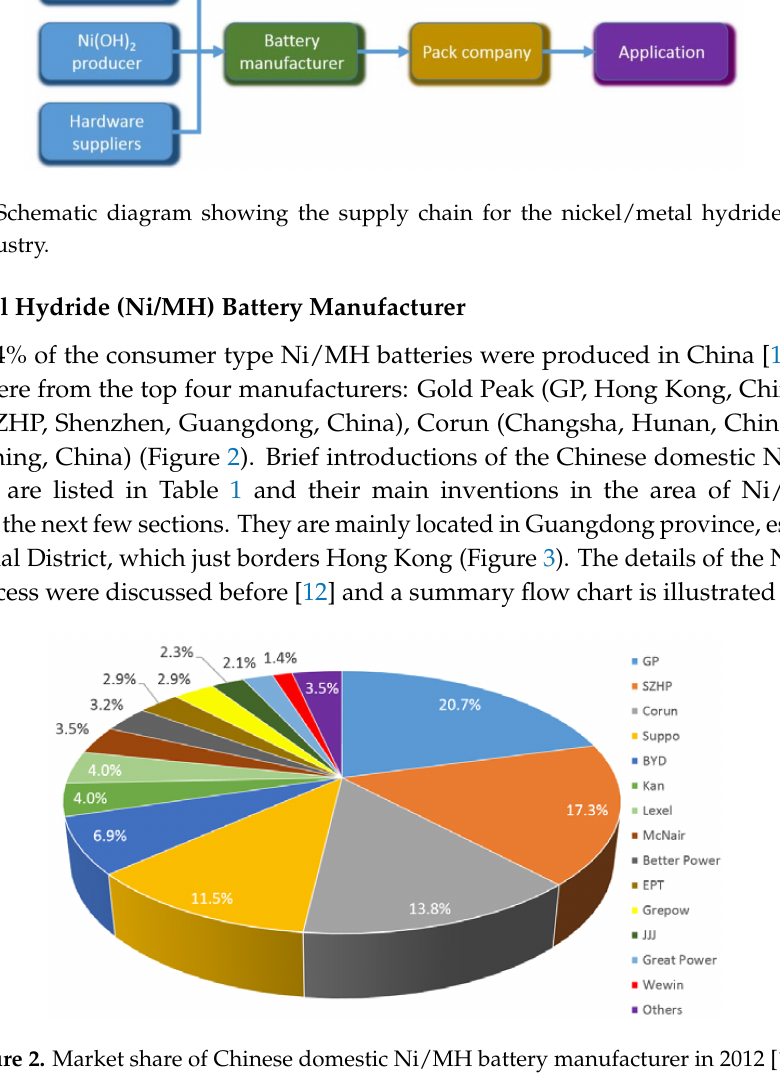
Figure 2. Market share of Chinese domestic Ni/MH battery manufacturer in 2012 [16]. Table 1. Brief introduction of the Chinese Ni/MH battery manufacturers included in this